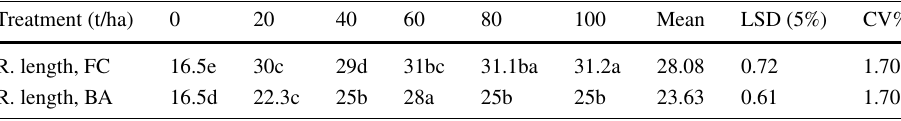
Table 5 Effect of filter cake and bagasse ash on experimental wheat root length Values with the same letter are not significantly different, t/ha, ton per hectare FC filter cake, R. length root length (cm), FC filter cake, BA